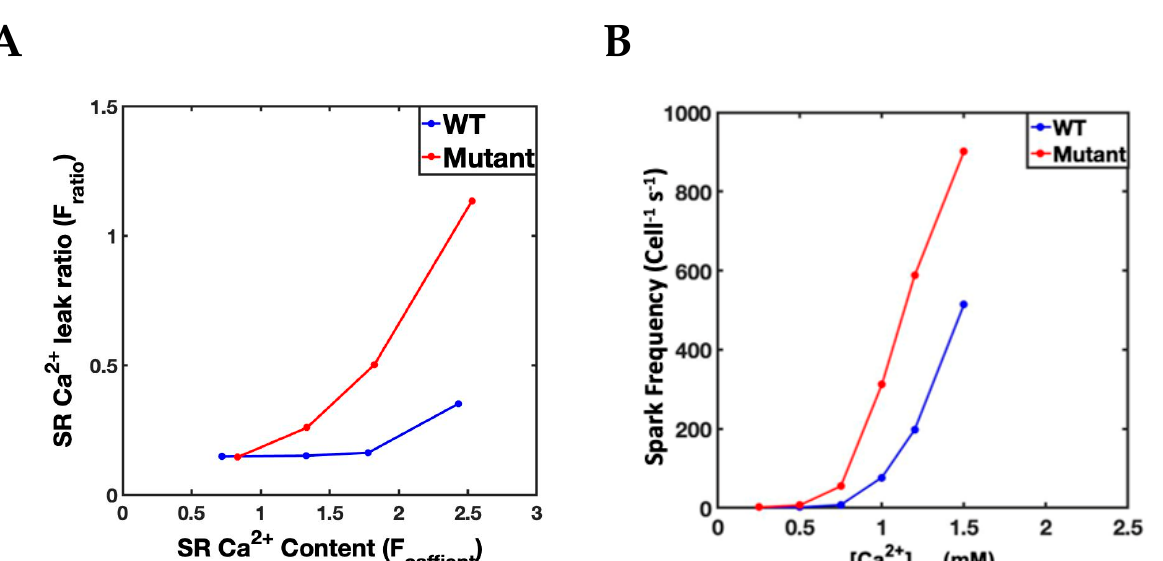
Figure 3. A comparison of the SR luminal dependence of mutant and wild-type myocytes Ca 2+ . ( A ) Experimentally measured values from Knollman and co-workers [32] comparing wild-type mice ventricular myocytes to transgenic mice ventricular myocytes harboring the CPVT mutation. ( B ) Experimental simulation with CPVT mutations detailed in Table 1 show that the Ca 2+ spark frequency in simulated Guinea pig ventricular myocytes follows a similar pattern to the experiments in mice.